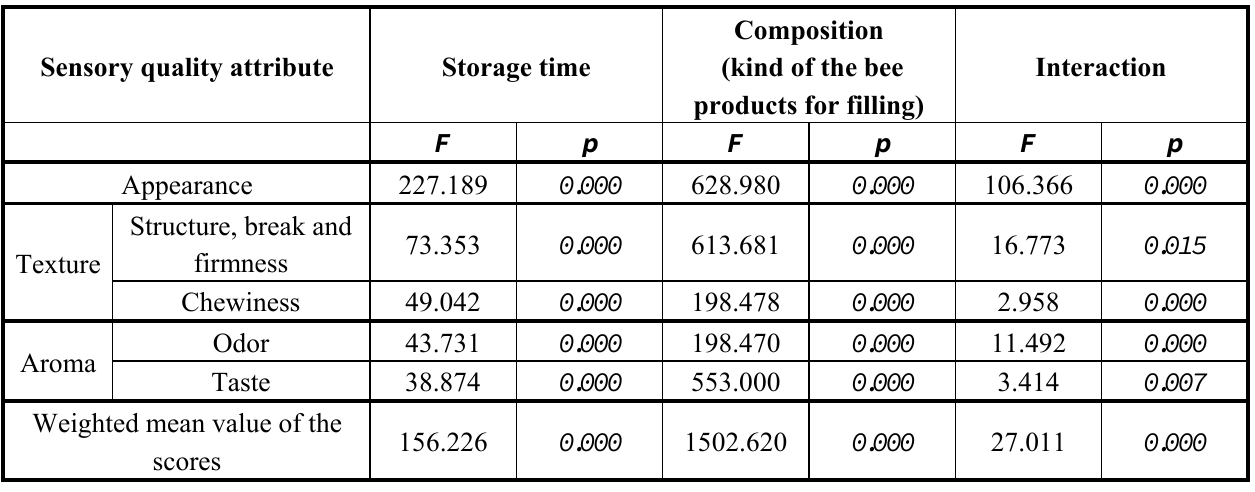
Table 3. Results of the analyses of variances for sensory attributes of the praline samples with different